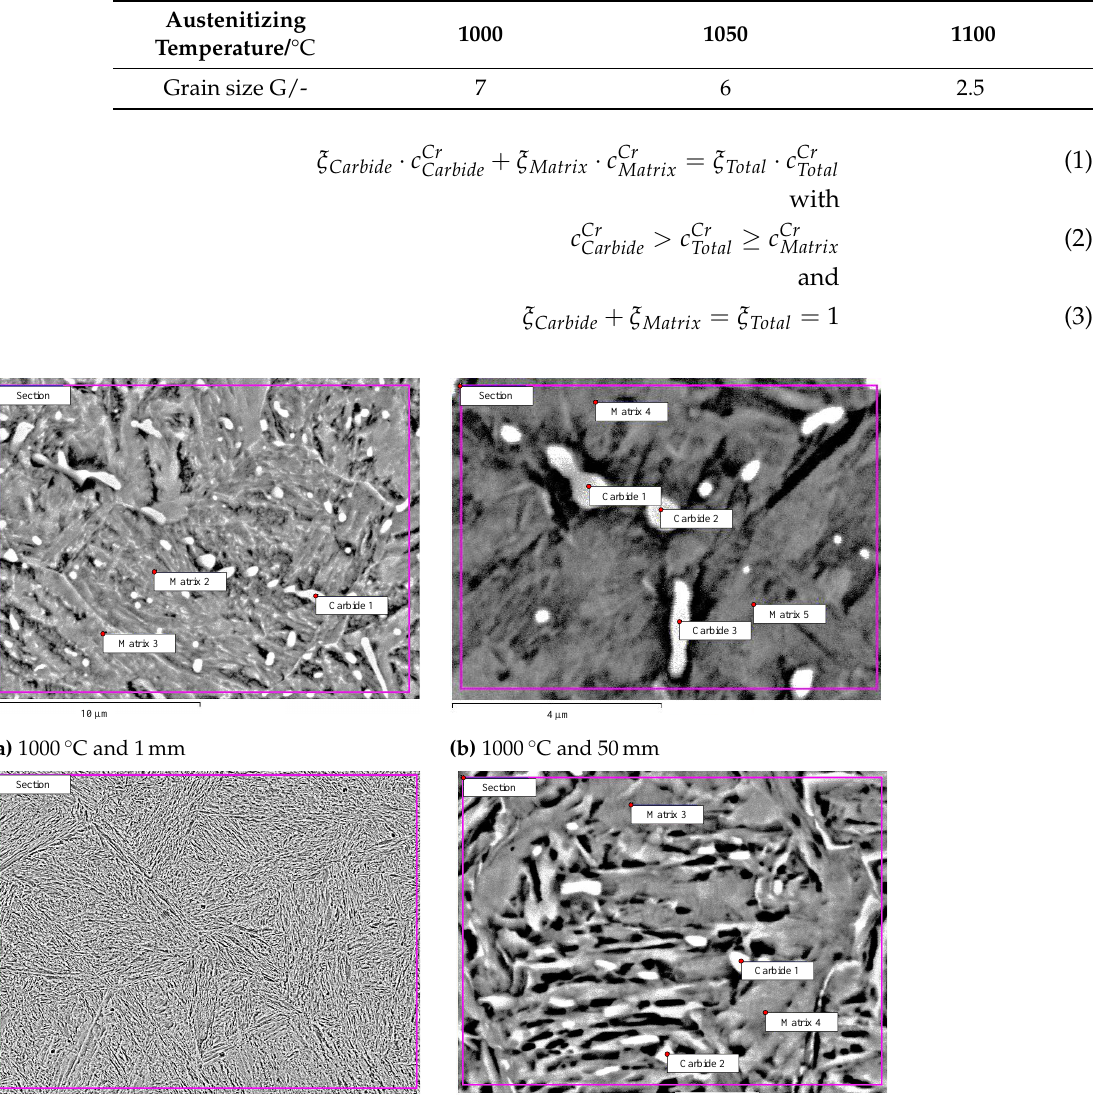
Table 6. Determined grain size G according to the work in [18] as a function of austenitizing temperatures in °C. The holding time including heating was 50min.